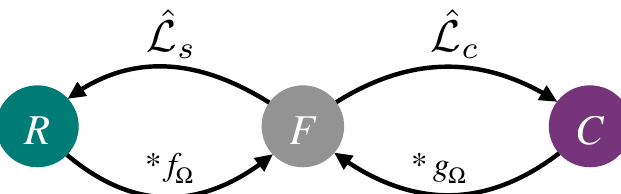
/ s act on the L c